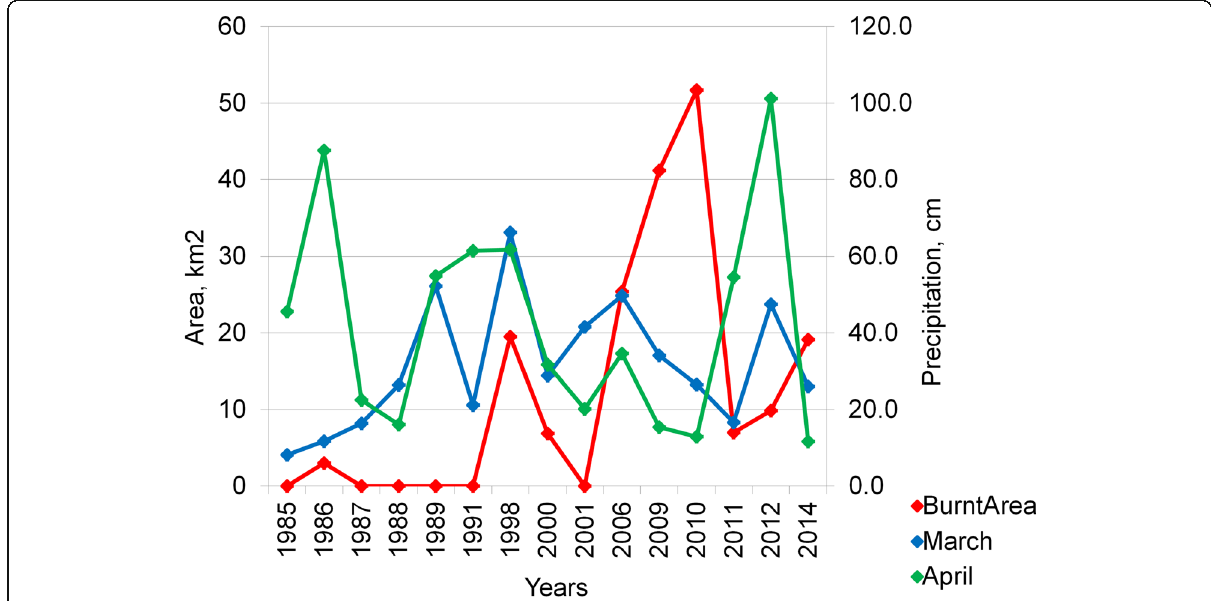
Fig. 8 Burnt area and sum of precipitations: March and April are the sums of March and April precipitation in the investigated